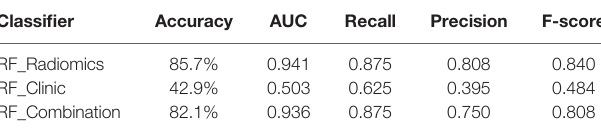
TABLE 3 | Predictive performance of machine-learning models with radiomic features, clinical features, and combined features in the independent test